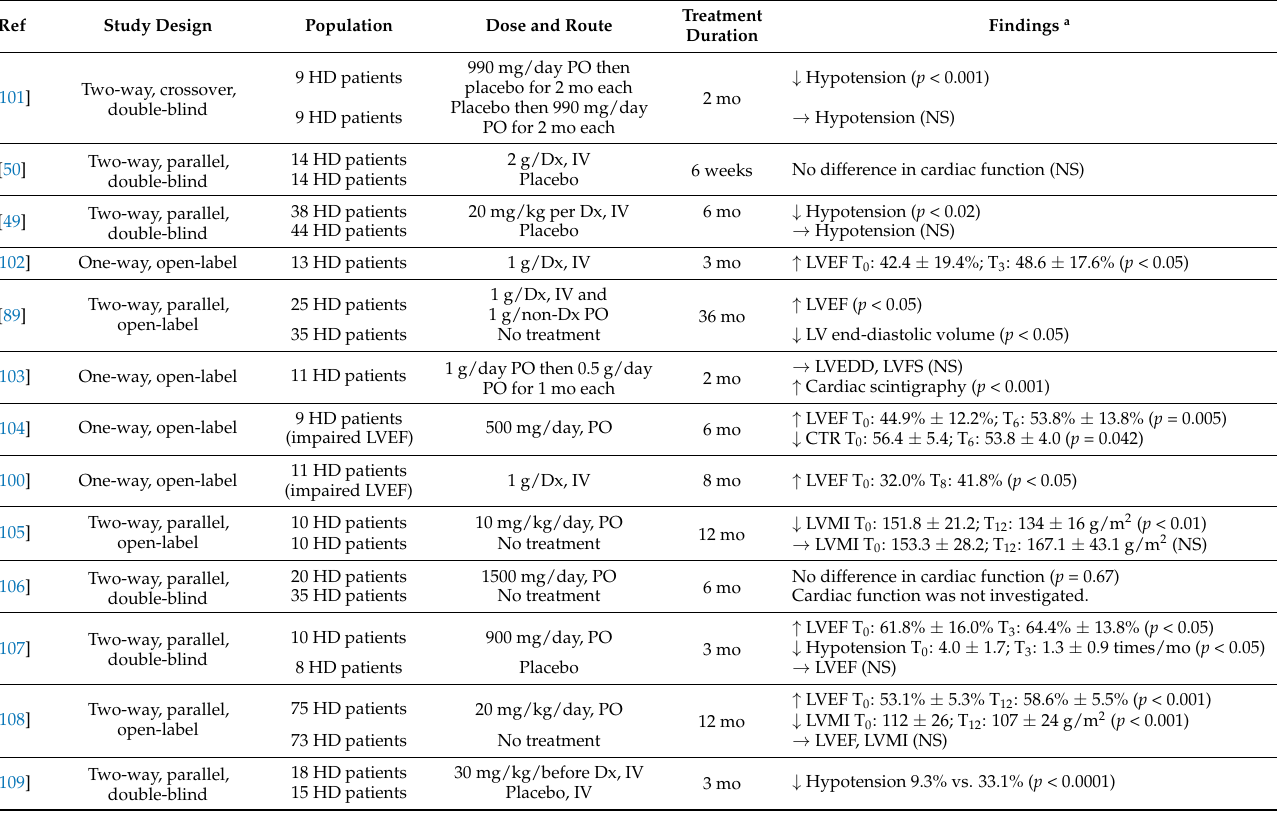
Table 2. Studies of the effect of levocarnitine on cardiac function and hypotension in dialysis